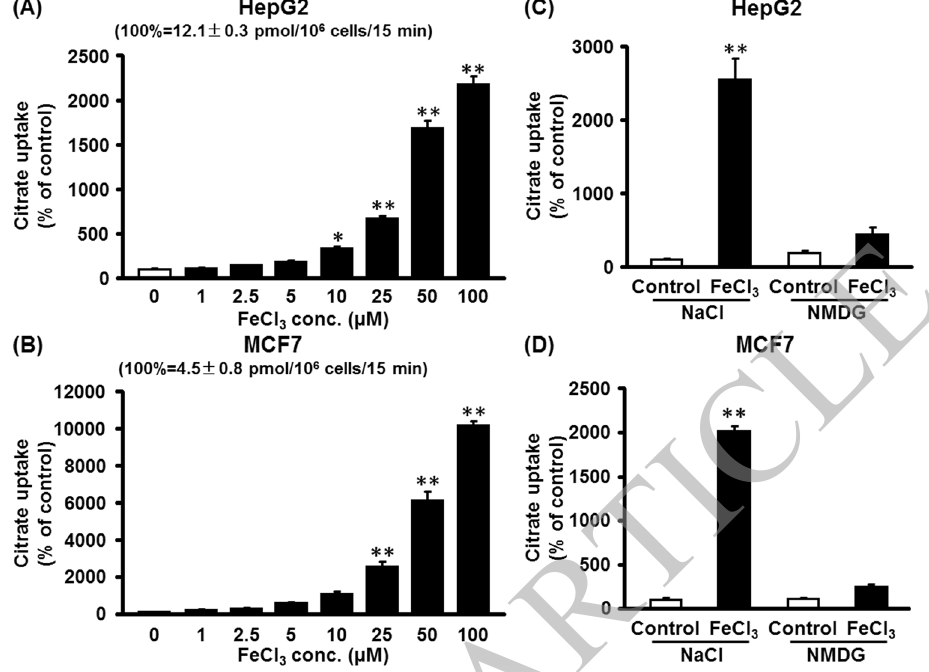
pathological conditions, we performed a dose-response study in HepG 2 cells (Fig. 3A) and MCF7 cells (Fig. 3B). We found significant stimulation of citrate uptake even at [Fe 3 + ] as low as 2.5 μ M when directly compared with uptake in the absence of Fe 3 + (paired Student’s t test; p < 0.05). The stimulation increased as [Fe 3 + ]increased even two forms in stimulating citrate uptake in MCF7 cells. When present at equal concentration (50 μ M), the potency of Fe 3 + to stimulate citrate uptake was at least 2-fold greater than the potency of Fe 2 + (Supplementary Fig. S2A). Obligatory Na + requirement for the Fe 3 + -stimulated citrate transport system.